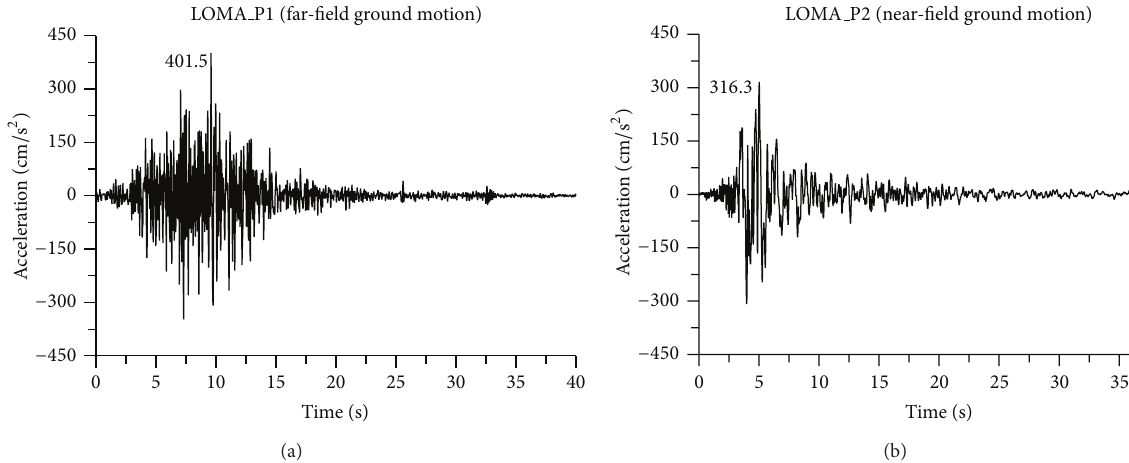
Figure 4: Acceleration time histories of (a) LOMA P1 (FF) and (b) LOMA P2 (NF) records.